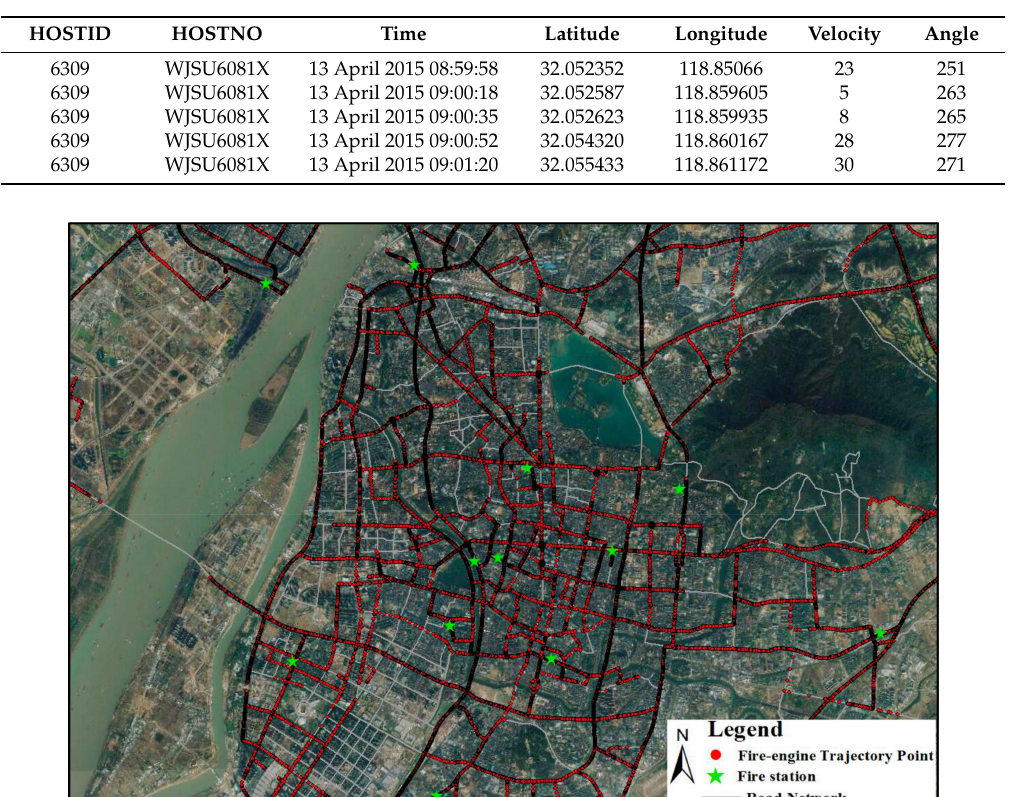
Figure 2. A sample of fire-engines trajectory points from 1 to 3 January 2015.